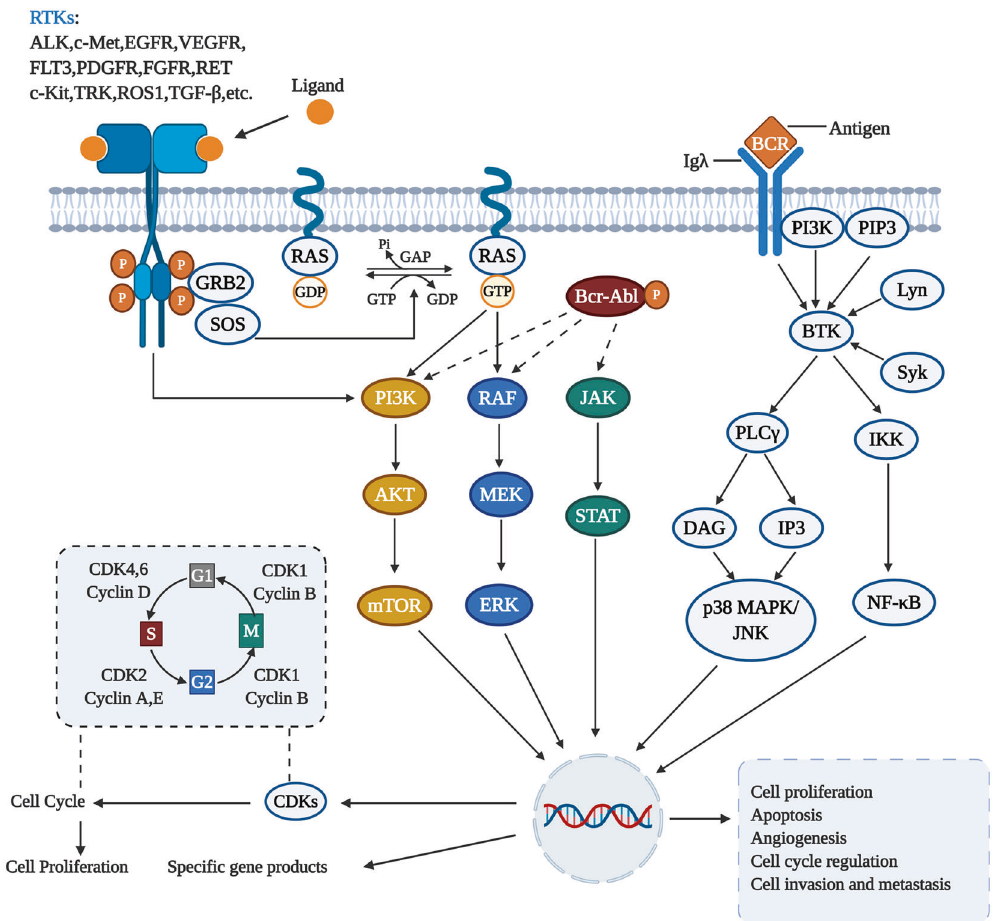
Fig. 2 Activation of different protein kinase-dependent pathways. The set of RTKs in fl uences a small number of intermediaries, such as phosphoinositide 3-kinase (PI3K) and mitogen-activated protein kinases (MAPK), thereby activating the complex signaling networks that are related to cell proliferation, differentiation, adhesion, apoptosis, and migration. The aggregation, activation, and depolymerization of the periodic CDK-cyclin complex are critical events driving cell cycle turnover. Figure created with